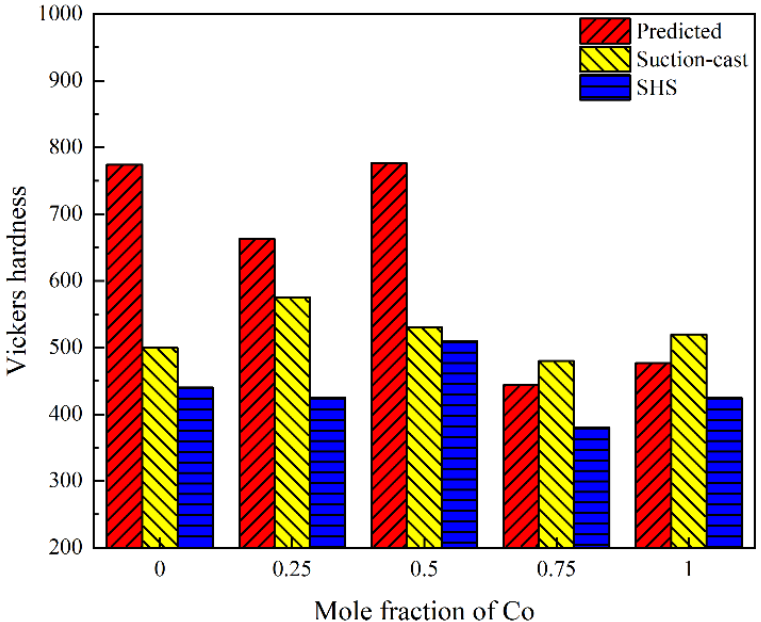
Figure 4. The predicted and experimental hardness of AlCo x CrFeNi (x= 0, 0.25, 0.5, 0.75, 1) HEAs.